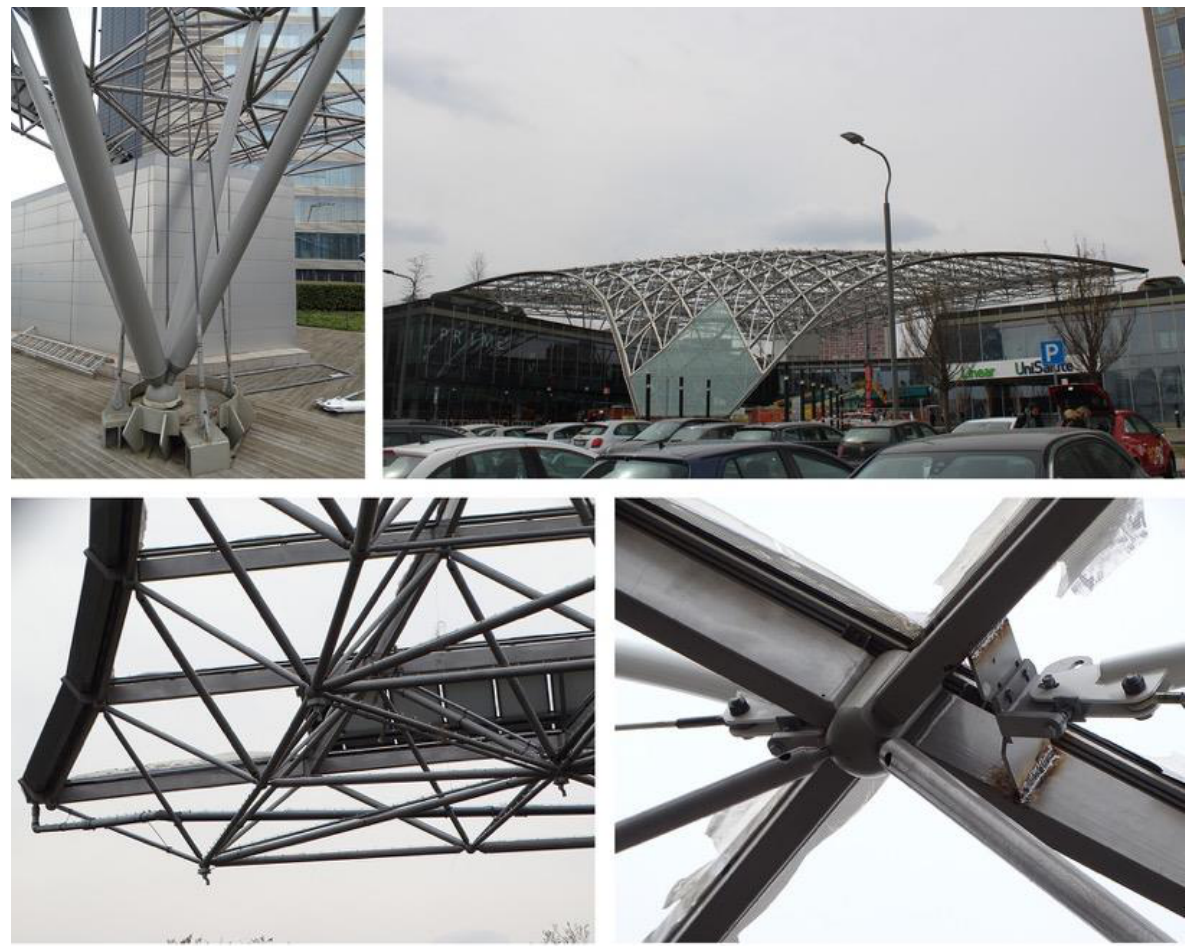
Figure 2. La Vela spatial grid structure.